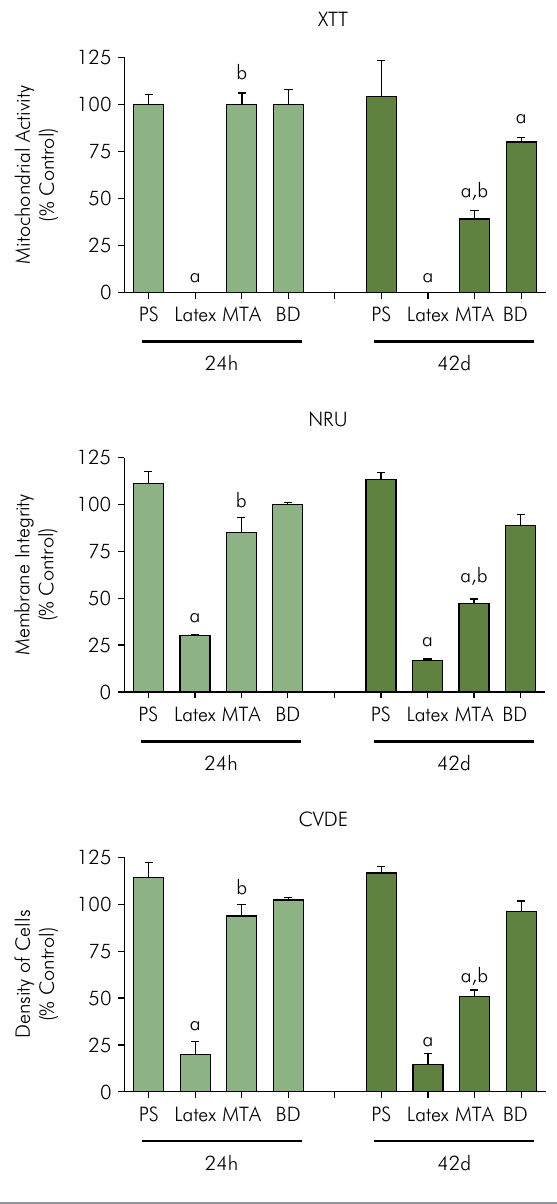
Figure 1. Cytotoxicity assay. Cytotoxic effects of test materials (Biodentine - BD and MTA Angelus) on human osteoblasts by XTT (A), Neutral Red Uptake (NRU) (B) or Crystal Violet Dye Exclusion (CVDE) (C) assays, expressed as a percentage of the control (cells exposed to extract media). Bars indicate mean ± standard deviation. The letter (a) indicates significant difference from the control group (p < 0.05). The letter (b) indicates significant difference between experimental times (p <